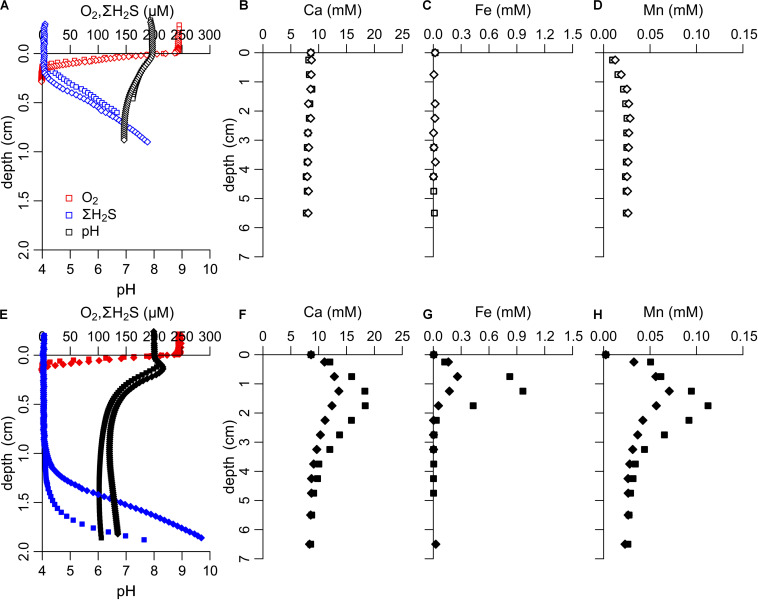
Pore water geochemistry of sediment in unamended incubations (upper row, open symbols) and stimulated incubations (bottom row, filled symbols). (A,E) Microsensor profiles of O2, ΣH2S and pH (t = 22 days). In the stimulated incubations a suboxic zone of ∼10 mm wide was present where both oxygen and sulfide were below detection limit, indicative of the activity of cable bacteria. (B–D,F–H) Pore water concentrations (t = 24 days) of Ca, Fe, and Mn were much higher in the stimulated compared to the unamended incubations, indicating dissolution of minerals stimulated by acidification of the suboxic zone through anodic sulfide oxidation by cable bacteria.